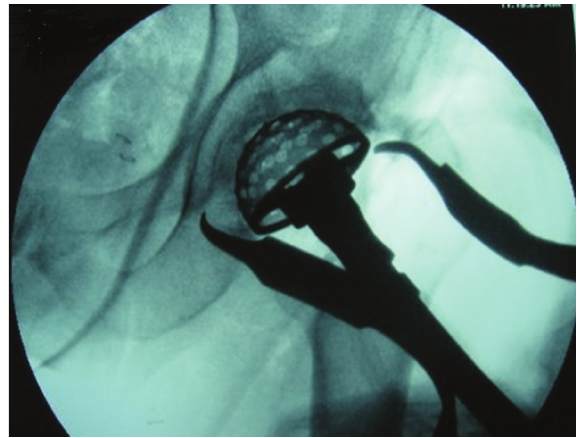
Figure 2: Preparation of the acetabulum with reamers is performed under fluoroscopic guidance.